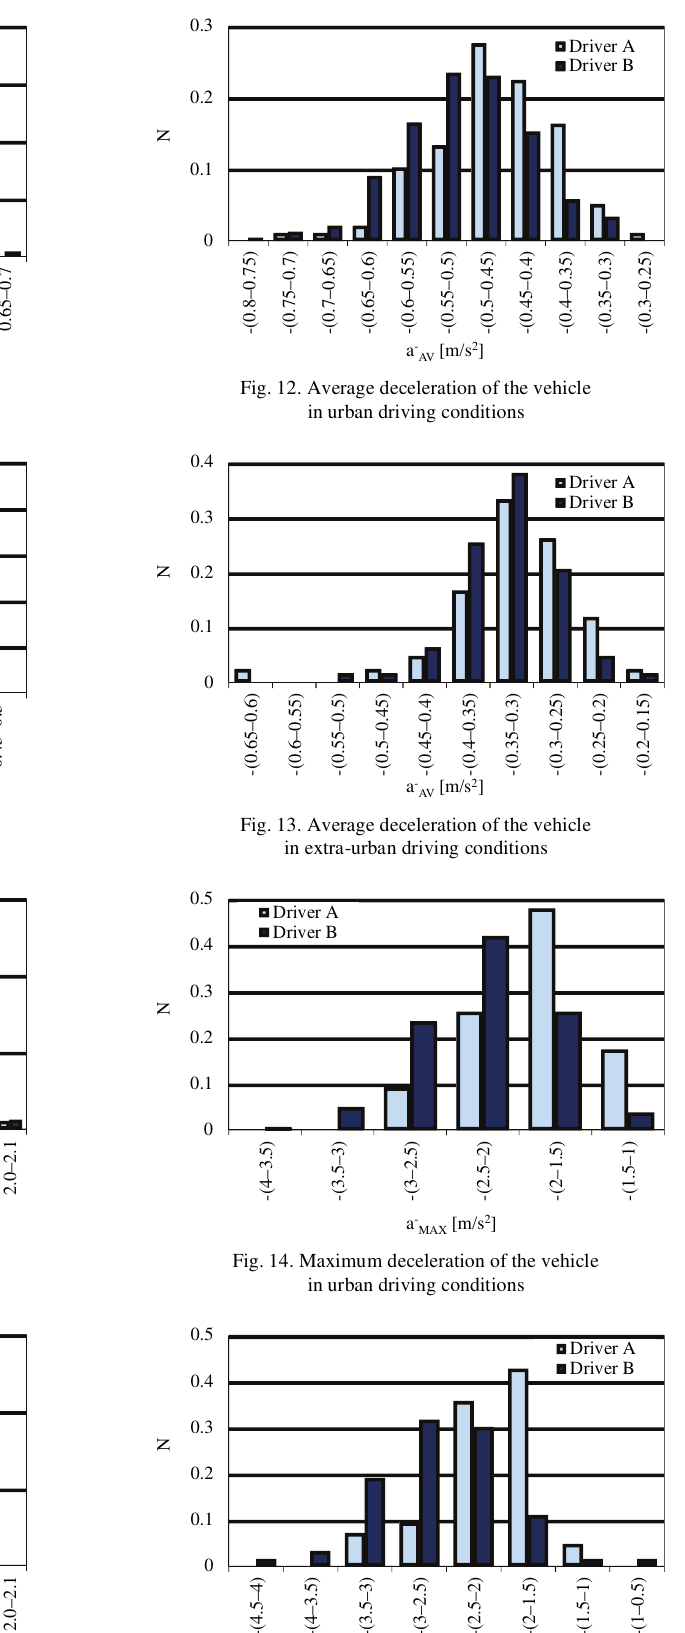
Fig. 15. Maximum deceleration of the vehicle in extra-urban driving